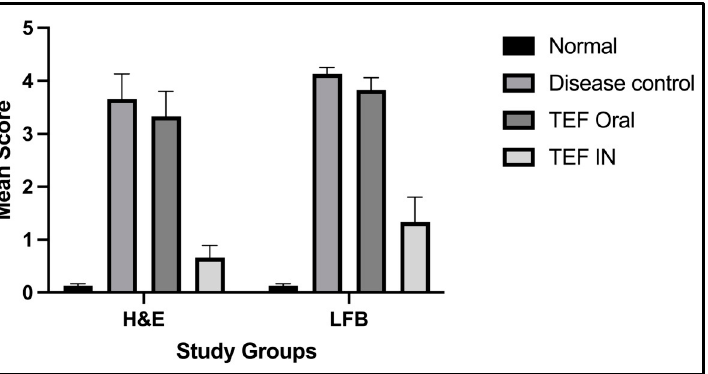
Figure 8. The unbiased semi-quantitative scoring for the histopathological sections where (0) corre- sponds to no demyelination and in fl ammation and (5) indicates complete demyelination and in- fl ammation. The IN administered TEF–miR-155-antagomir-loaded NLCs group has exhibited sig- ni fi cant ( p < 0.002) recovery with minimal in fl ammation and demyelination compared to TEF oral group.